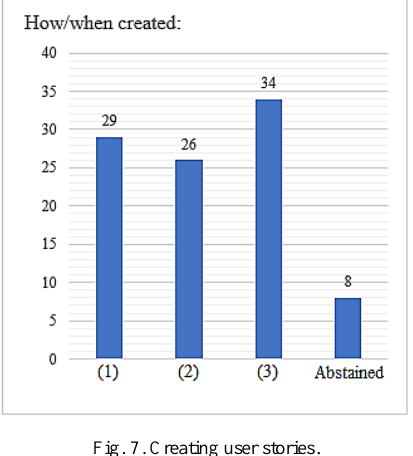
Fig. 7. Creating user stories.